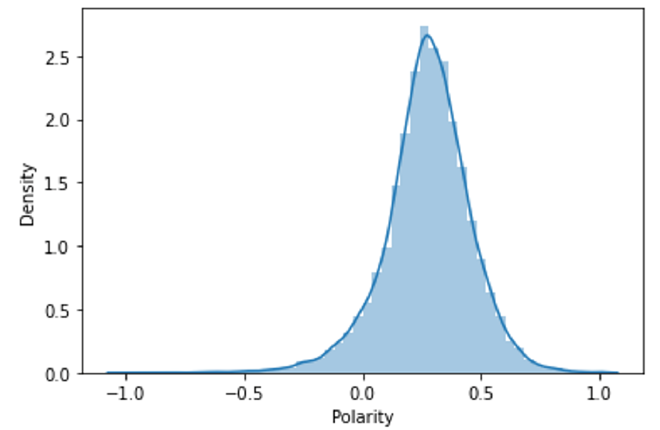
Figure 3. Density of the “Polarity” attribute obtained with